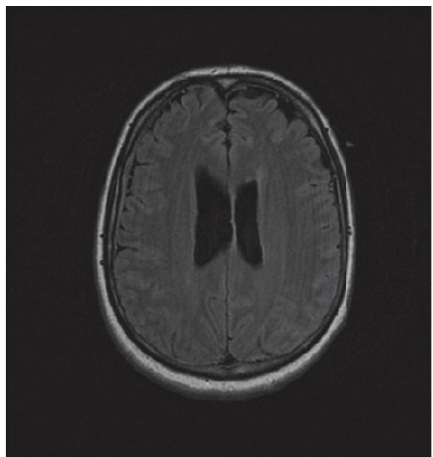
Figure 1: Cranial MRI image showing thin subdural hematoma in the right frontotemporal region.